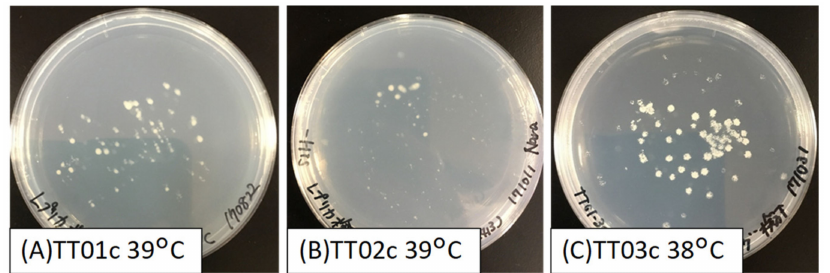
Figure 1. Colonies on replica plates of control strains cultivated under high temperature conditions